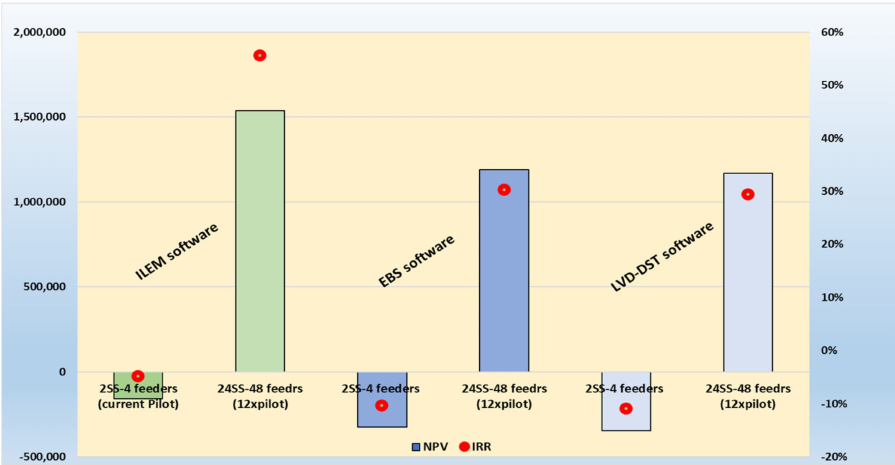
Figure 10. NPV (in EUR, left side of the figure) and IRR (% in the right side) based on WTP scenario for the three-software platform when the pilot is scaled up 12 times the pilot